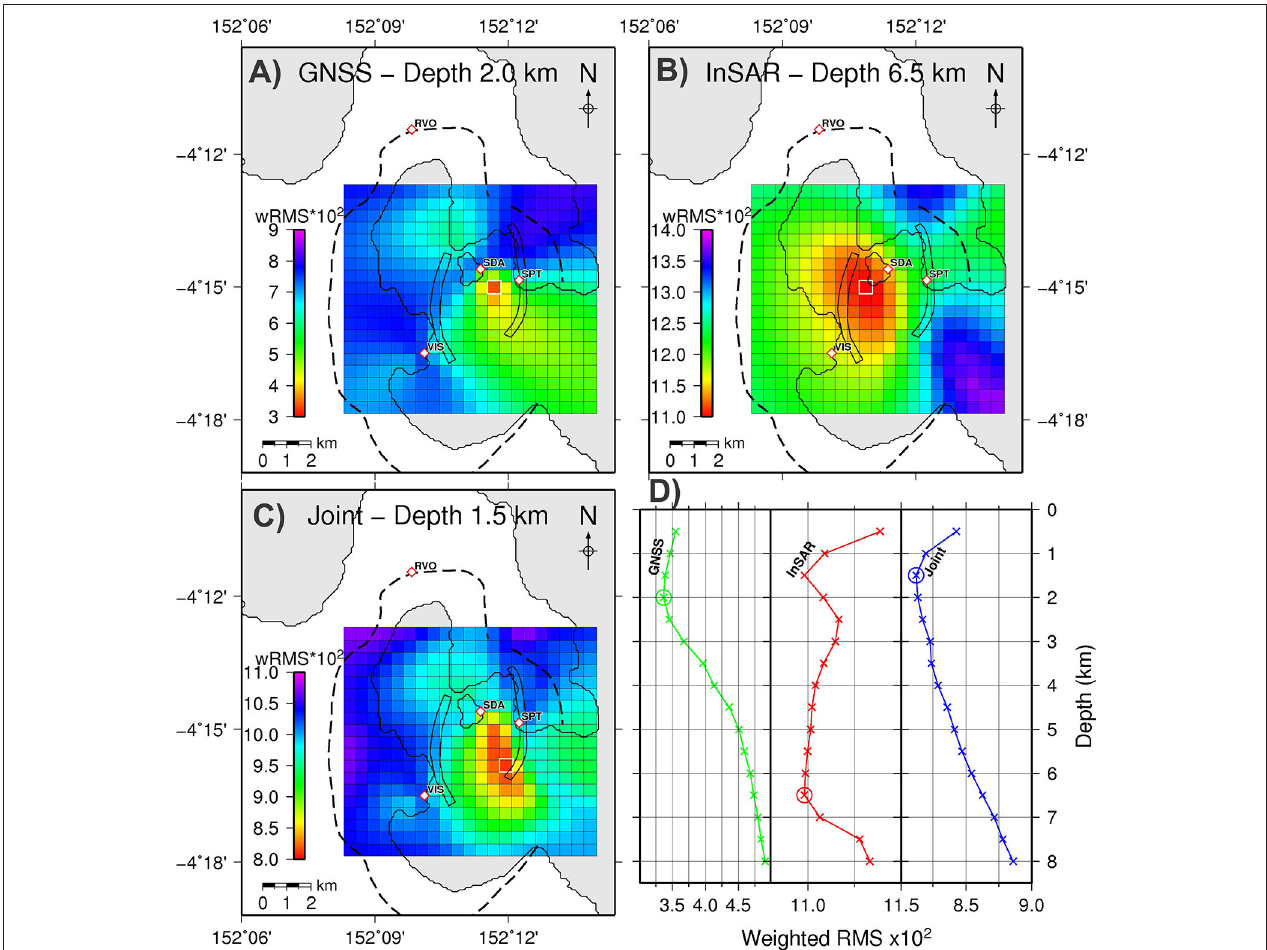
FIGURE 6 | Plots of wRMS resulting from grid searches (Step 1) for the best source location for: (A) GNSS-only, (B) InSAR-only, (C) Joint inversion. White outlined square highlights the overall best fitting source for each inversion. (D) Plot of the depth variation of the minimum wRMS for each inversion. Circles highlight the overall best fit source for each inversion. Animations cycling through depth slices for each grid search are given in the Supplementary Material . Black dashed line indicates the general topographic rim of the nested caldera complex and the black polygons outline the two zones of concentrated seismicity (described in Figure 2 ). Red outlined diamonds indicate the location of the four GNSS